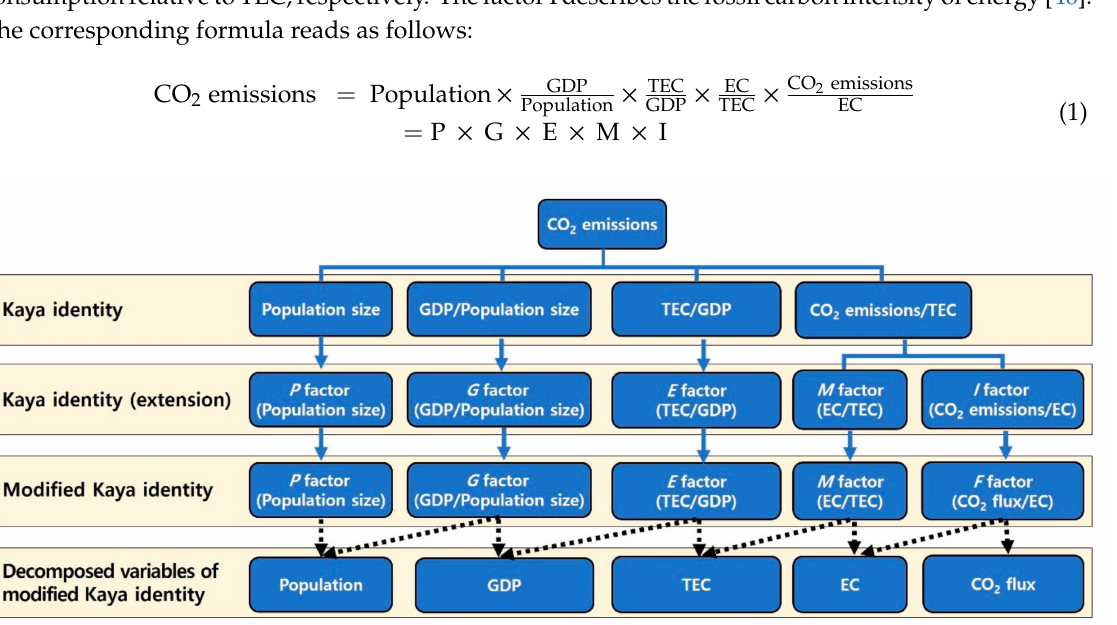
Figure 1. A hierarchy of Kaya identity representations including the decomposed